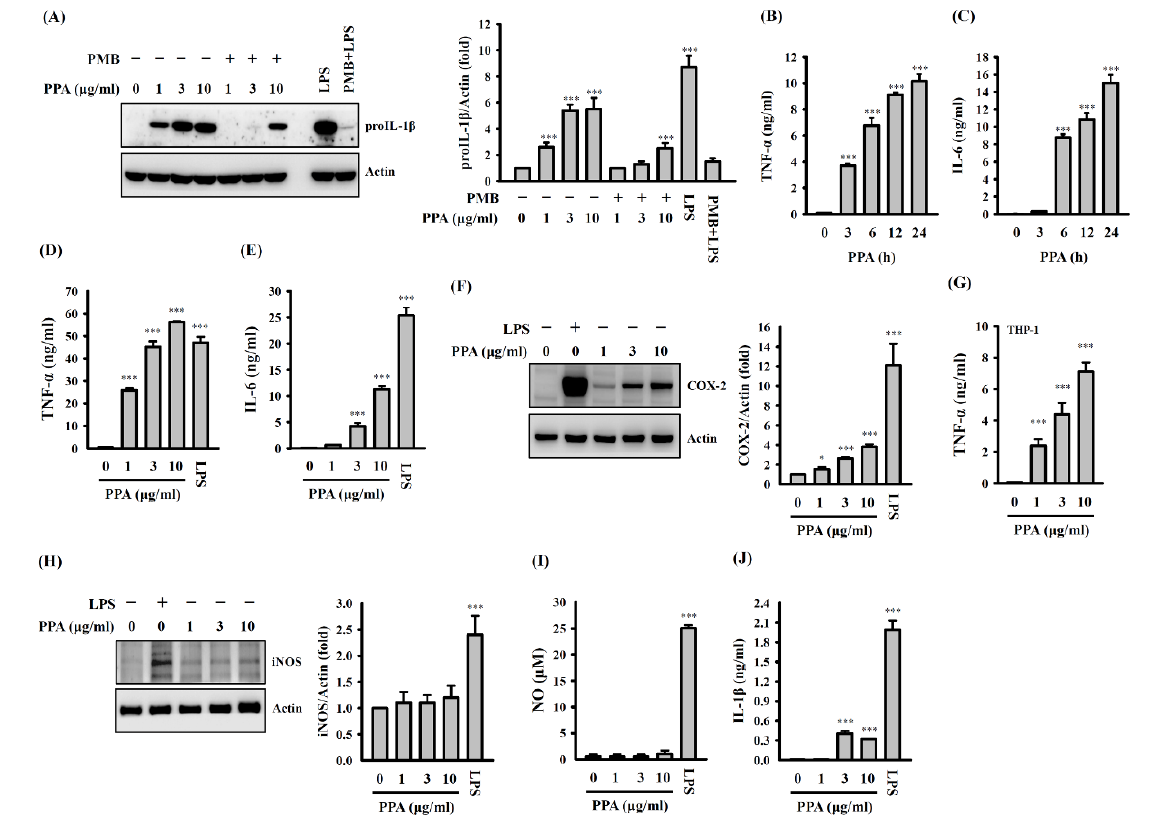
Figure 2. Effect of PPA on inflammatory mediator expression. ( A ) Effect of PMB on proIL-1 β expression in PPA- or LPS-stimulated J774A.1 macrophages. ( B ) TNF- α expression in PPA-stimulated J774A.1 macrophages. ( C ) IL-6 expression in PPA-stimulated J774A.1 macrophages. ( D ) TNF- α expression in PPA- or LPS-stimulated RAW264.7 macrophages. ( E ) IL-6 expression in PPA- or LPS-stimulated RAW264.7 macrophages. ( F ) COX-2 expression in PPA- or LPS-stimulated RAW264.7 macrophages. ( G ) TNF- α expression in PPA-stimulated THP-1 macrophages. ( H ) iNOS expression in PPA- or LPS-stimulated RAW264.7 macrophages. ( I ) NO expression in PPA- or LPS-stimulated RAW264.7 macrophages. ( J ) IL-1 β expression in PPA- or LPS-stimulated RAW264.7 macrophages. * p < 0.05 and *** p < 0.001 compared to control cells.